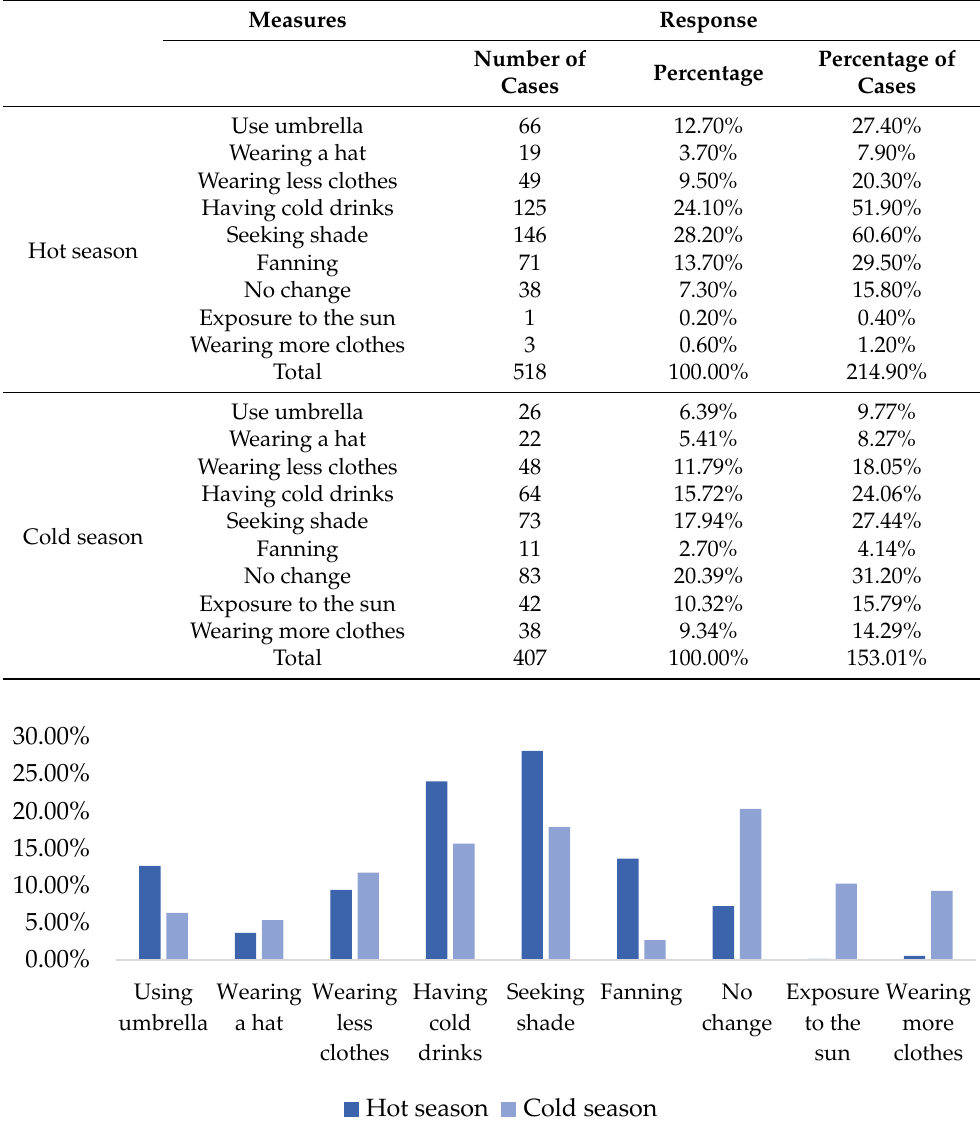
Table 13. Descriptive statistics of adaptive behavior.